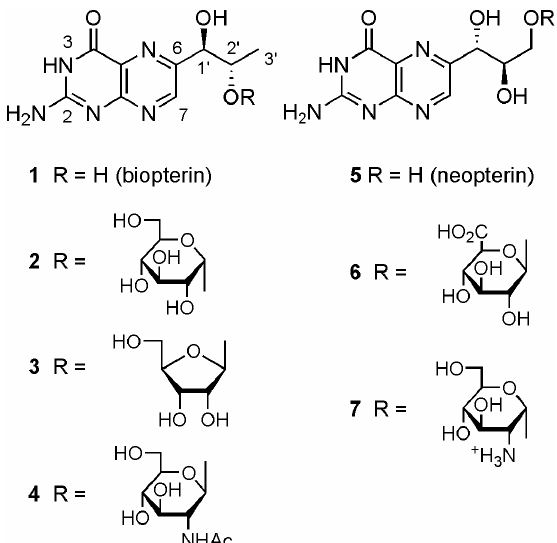
Figure 1: Structures of biopterin, neopterin, and their glycosides